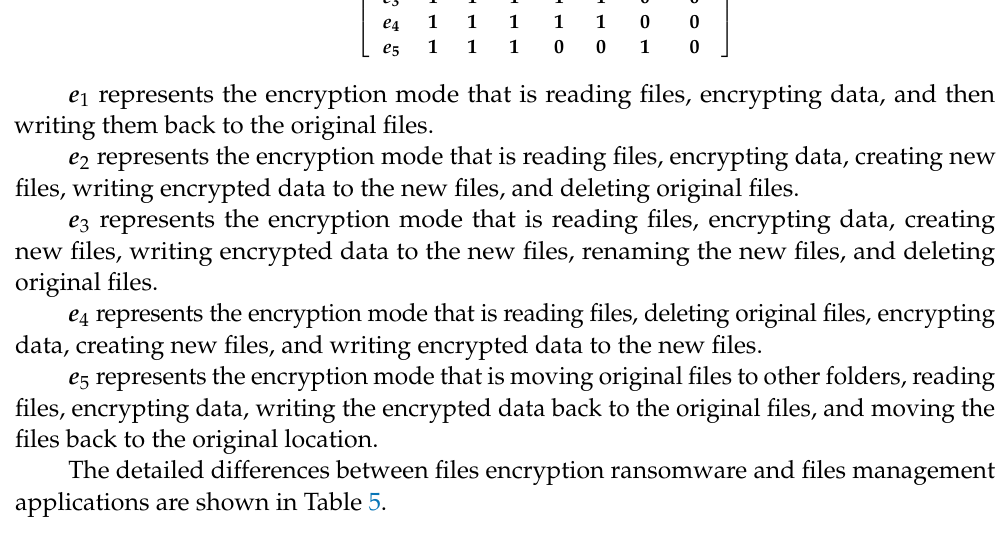
Table 5. Differences between files encryption ransomware and goodware applications. Files Encryption Ransomwares